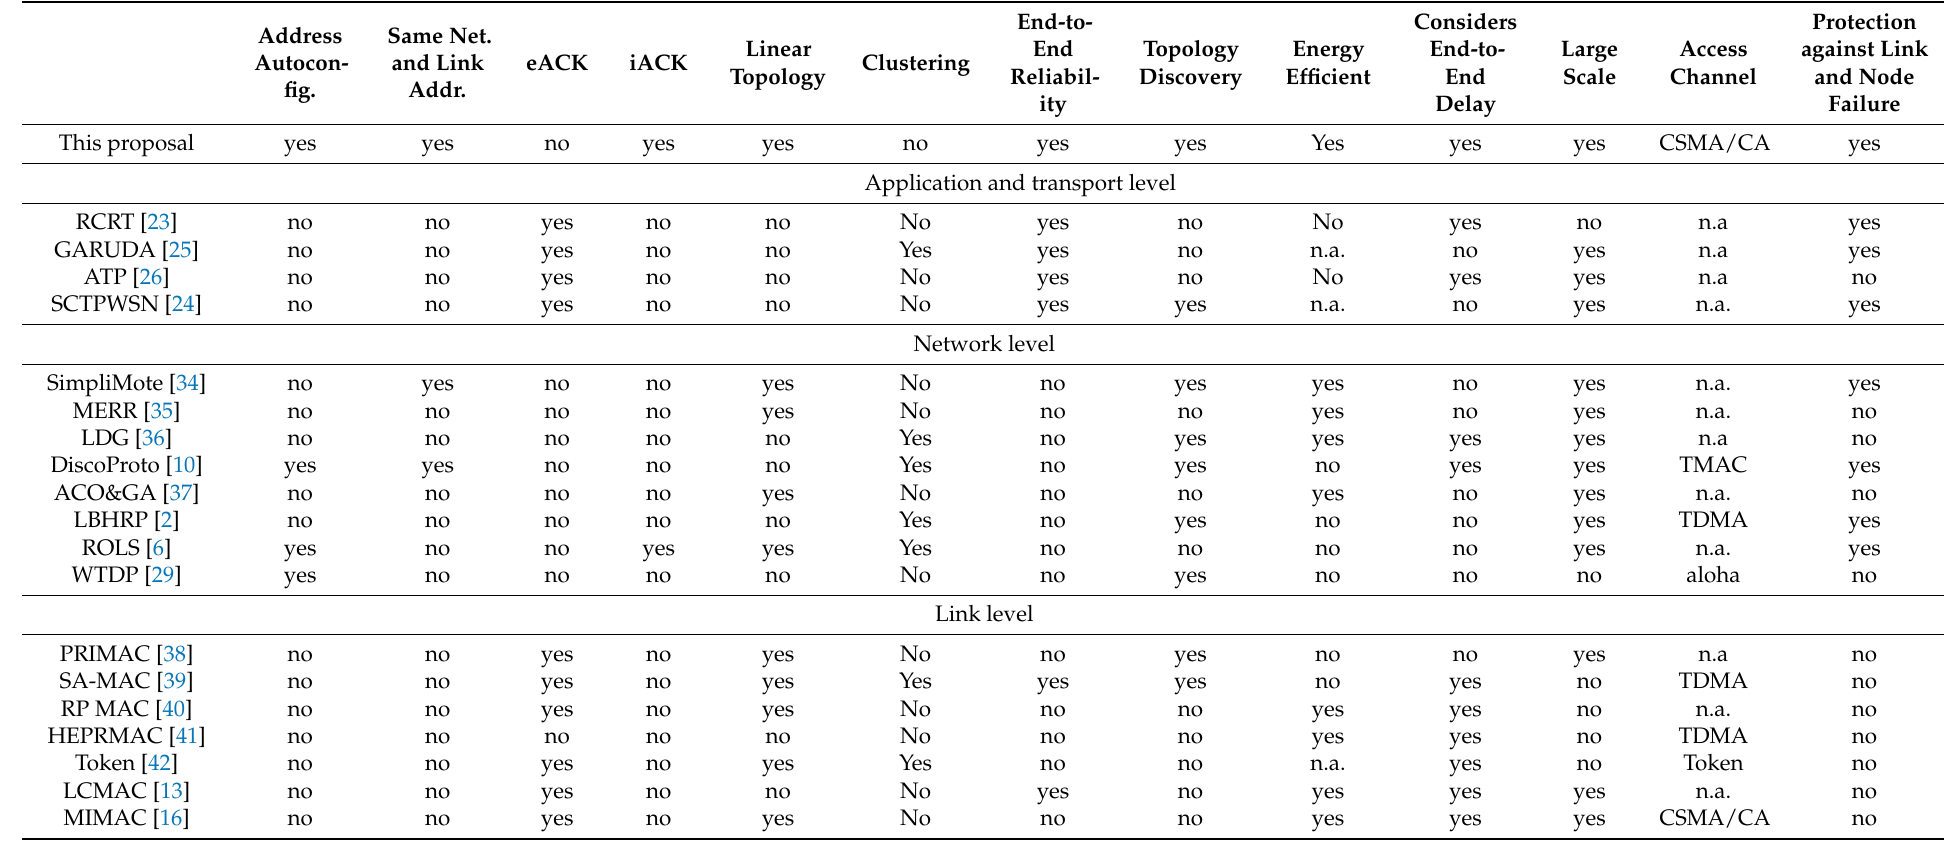
Table 1. Comparison of LPWAN